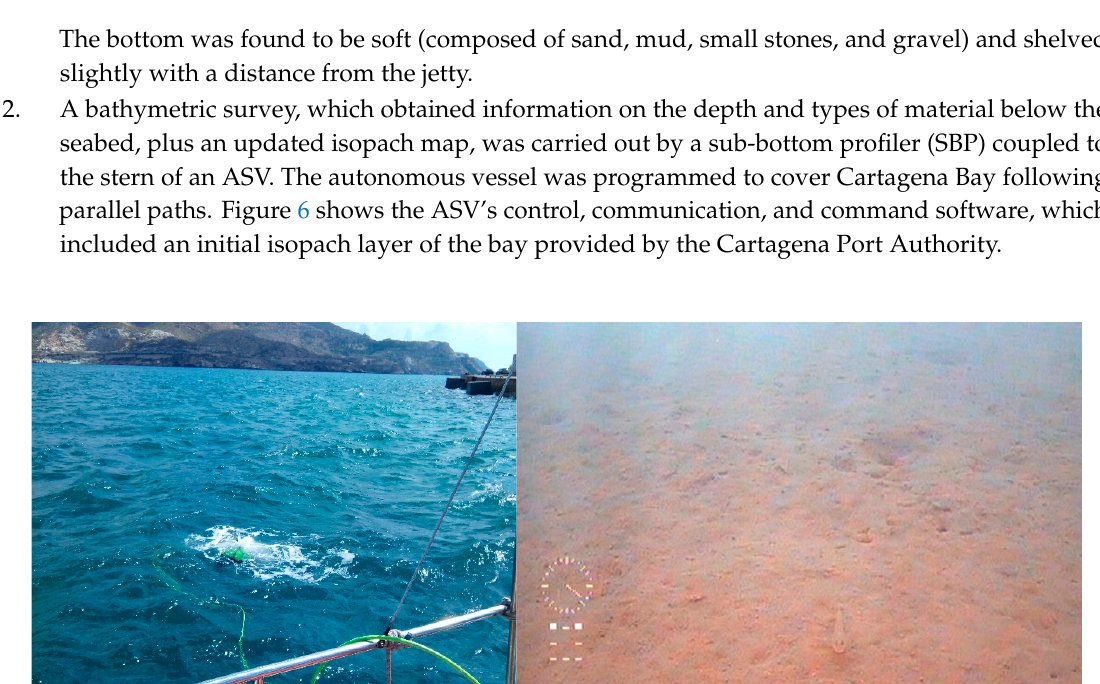
Figure 5. Robot on deployment (left) and an image of the seabed (right).